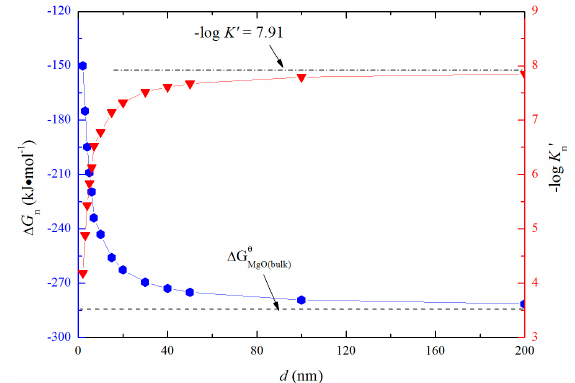
Figure 6. Apparent equilibrium constants of Mg-deoxidaiton in liquid iron at 1873 K.